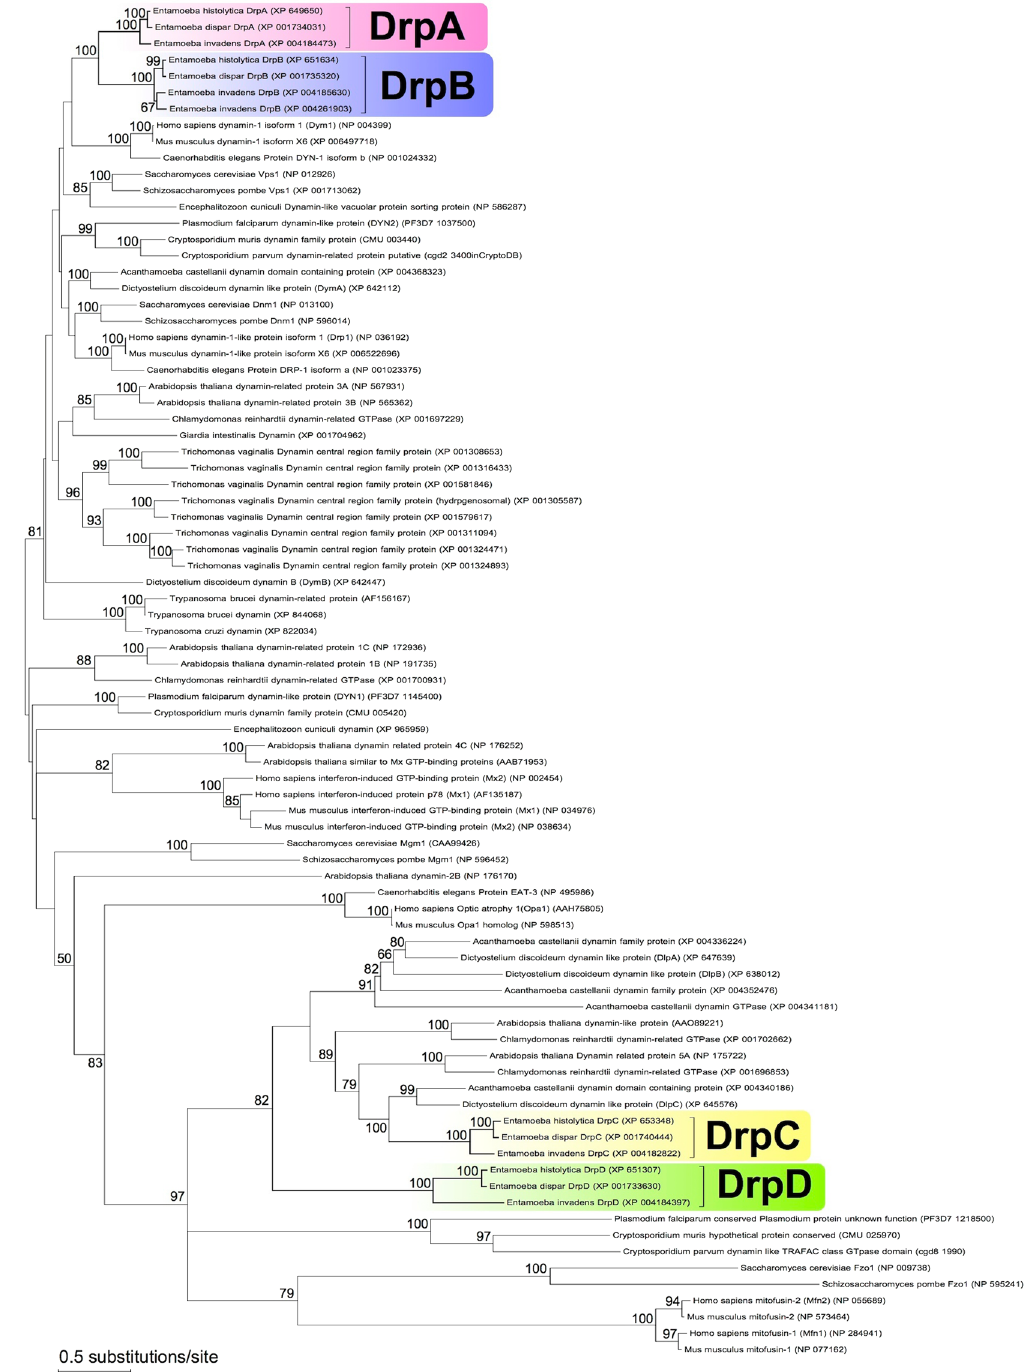
Figure 1. Phylogenetic reconstruction of dynamin superfamily proteins. The maximum likelihood (ML) best tree inferred by the LG model with four categories of among-site rate variation ( + G, parameter = 1.4857) and the rate variation model allowed for some sites to be evolutionarily invariable ( + I, 0.5029% sites). Bootstrap proportions by the ML method (100 replicates) are attached to the internal branches. Branches with less than 50% bootstrap support are